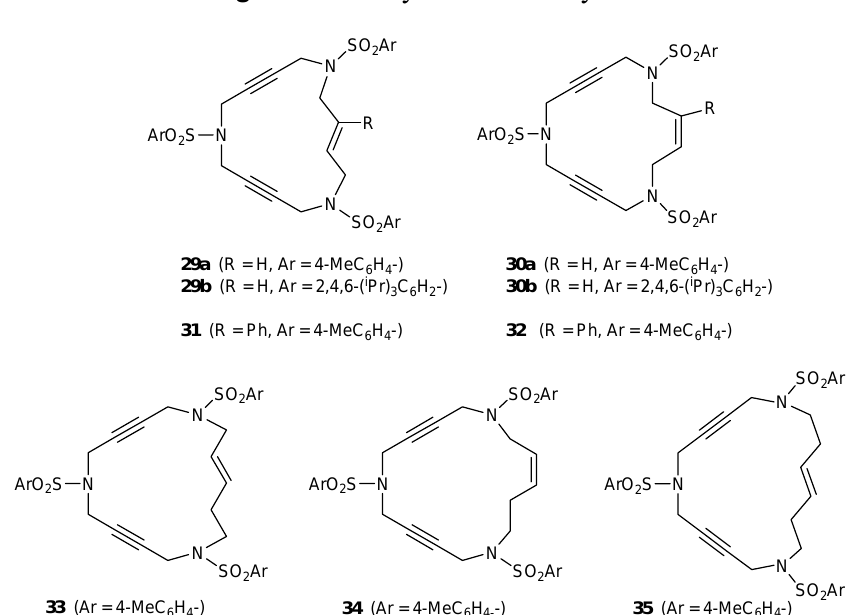
Figure 3. Enediyne azamacrocycles.